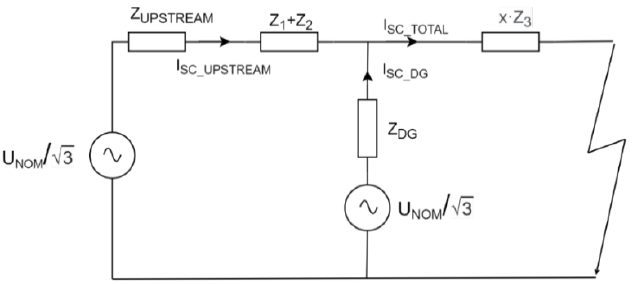
Figure 9. Calculating the upstream (main grid) contributing short-circuit current.